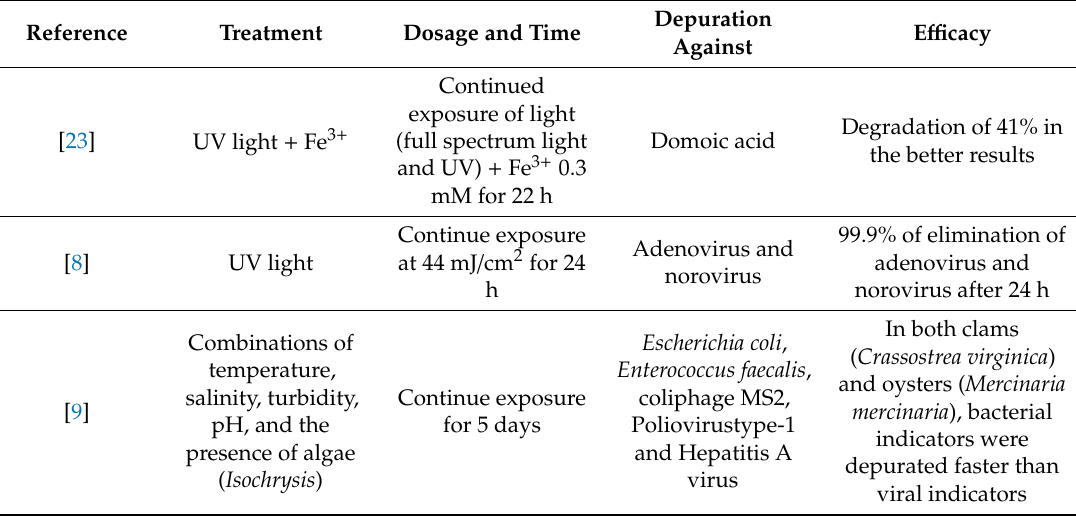
Table 1. Treatments applicable to depuration